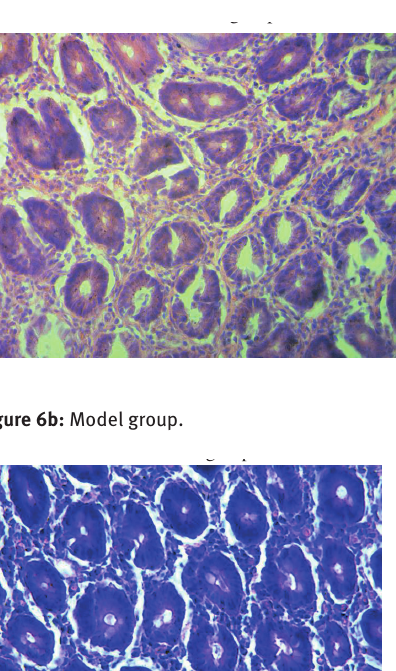
Figure 6a: Normal group.